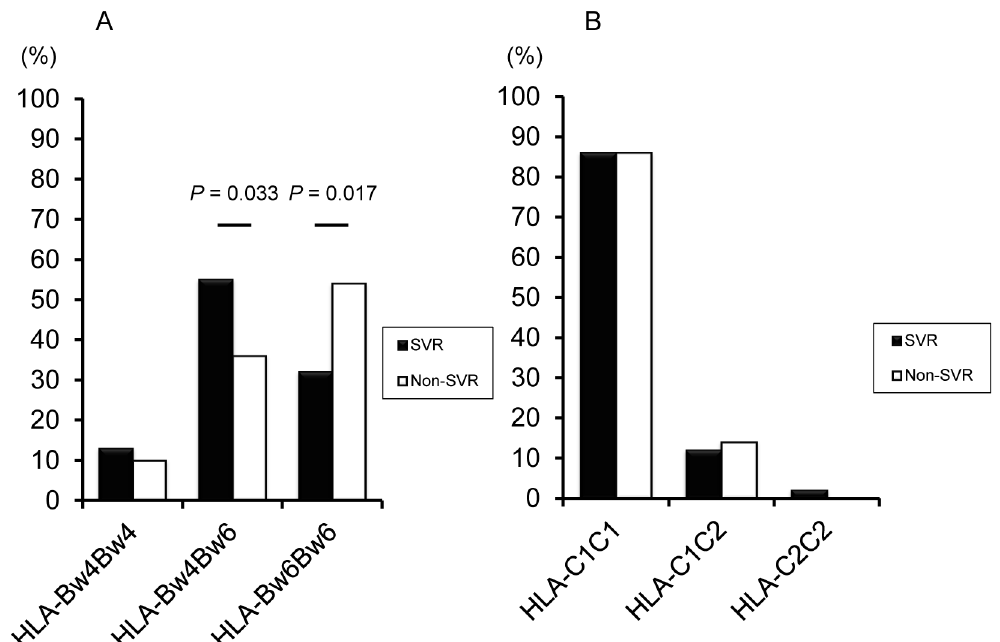
Figure 1. Frequency of HLA - Bw and -C alleles in 56 patients with a sustained virological response (SVR) and 59 patients with a non-SVR to pegylated interferon and ribavirin therapy of chronic hepatitis C.